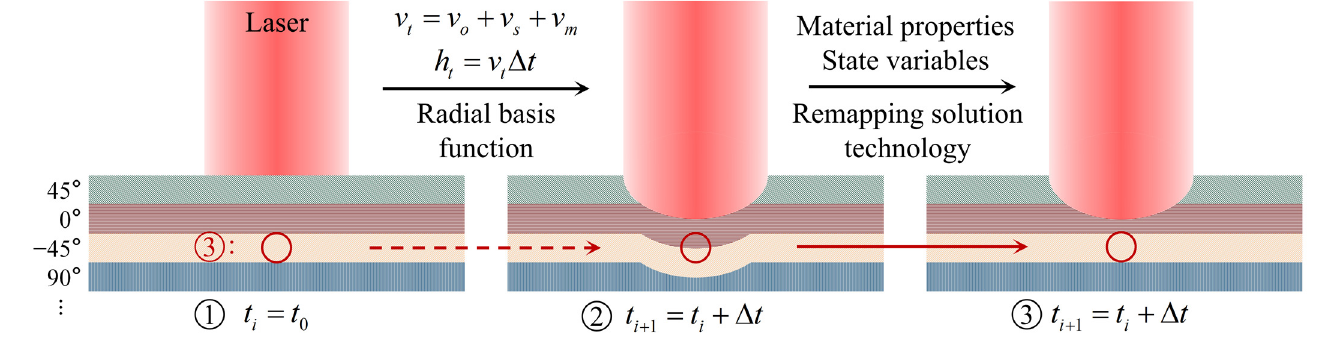
Figure 4. The flowchart of adaptive mesh algorithm for multilayer material.